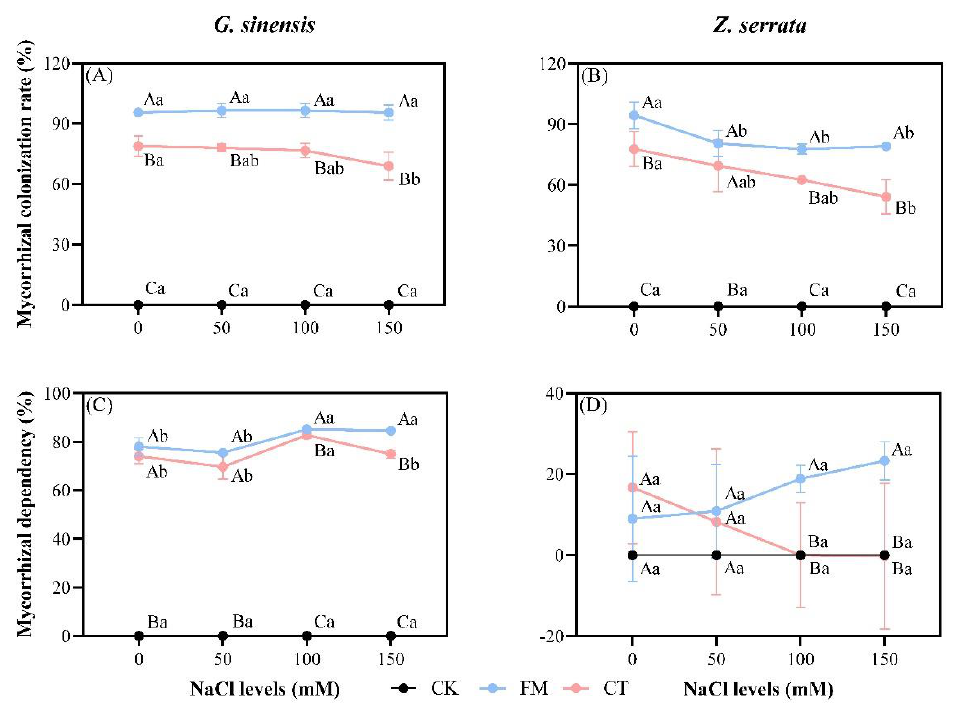
Figure 2. Variations in the mycorrhizal colonization rate and dependency between treatments. ( A ) mycorrhizal colonization rate of G. sinensis different treatments; ( B ) mycorrhizal colonization rate of Z. serrata different treatments; ( C ) mycorrhizal dependency of G. sinensis different treatments; ( D ) mycorrhizal dependency of Z. serrata different treatments. Uppercase letters indicate significant differences between various inoculation treatments under the same salt levels ( p < 0.05). Lowercase letters indicate significant differences between various salt concentrations under the inoculation treatments ( p < 0.05).